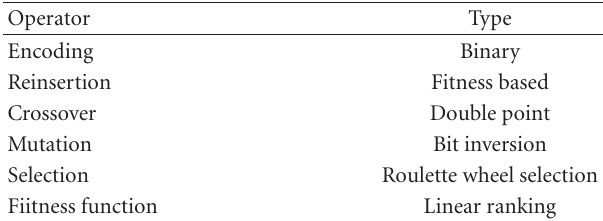
Table 3: Genetic